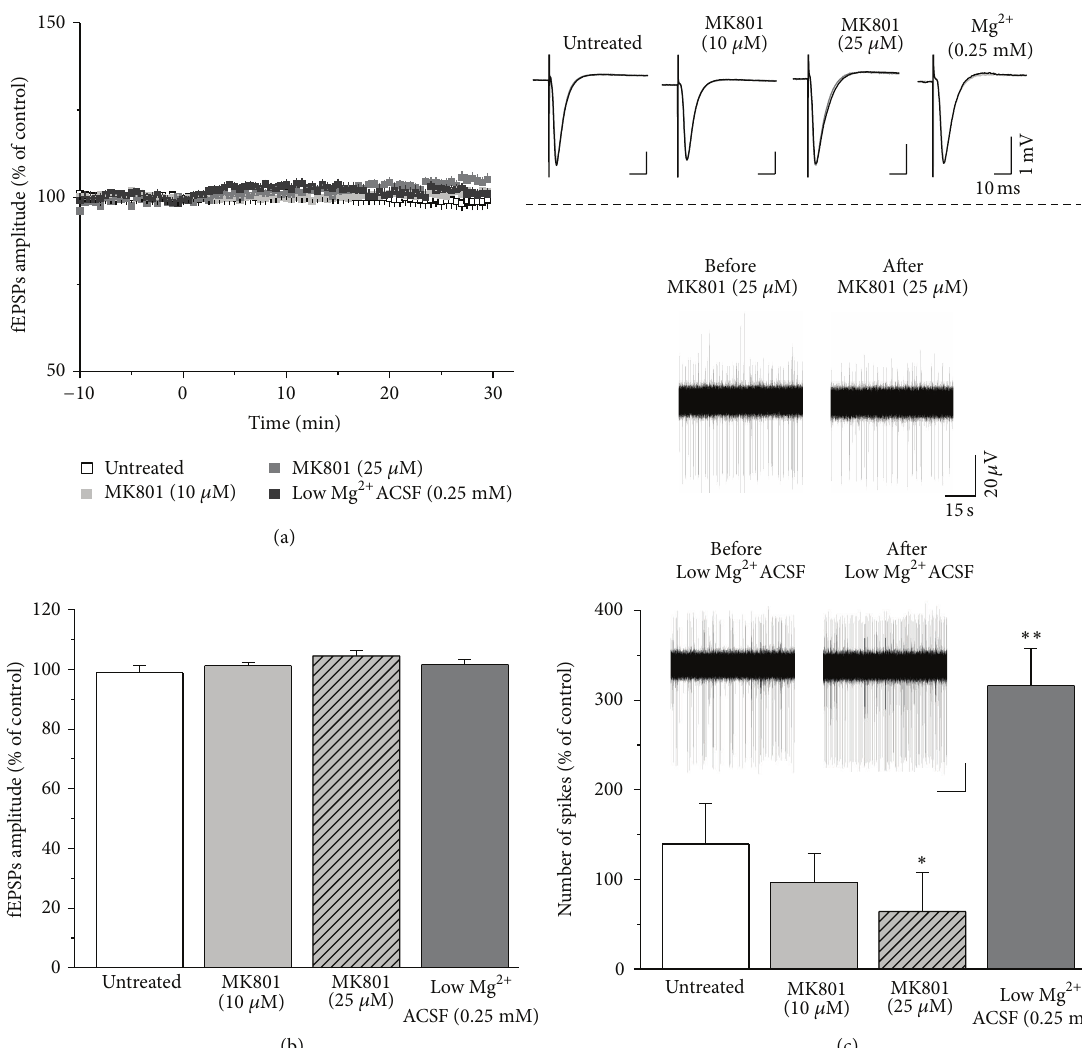
Figure 3: NMDA receptors mediate spontaneous activity but not fEPSPs. Blocking (MK801) or enhancing (low-Mg 2+ ACSF) NMDAR function did not influence fEPSPs (a). Right panel shows representative fEPSPs before (grey) and after (black) treatment. Bar graphs show the average of the fEPSPs amplitudes of the 25–30 min period after treatment (b). In contrast, MK801 dose dependently reduced spiking frequency and low Mg 2+ ACSF enhanced firing rate (untreated versus MK801 in 25 𝜇 M: 𝑃 = 0.035 and untreated versus low Mg 2+ ACSF: 𝑃 = 0.004 ) (c). Inset shows representative spike trains. Error bars show SEM; ∗ 𝑃 ≤ 0.05 , ∗∗ 𝑃 ≤ 0.01